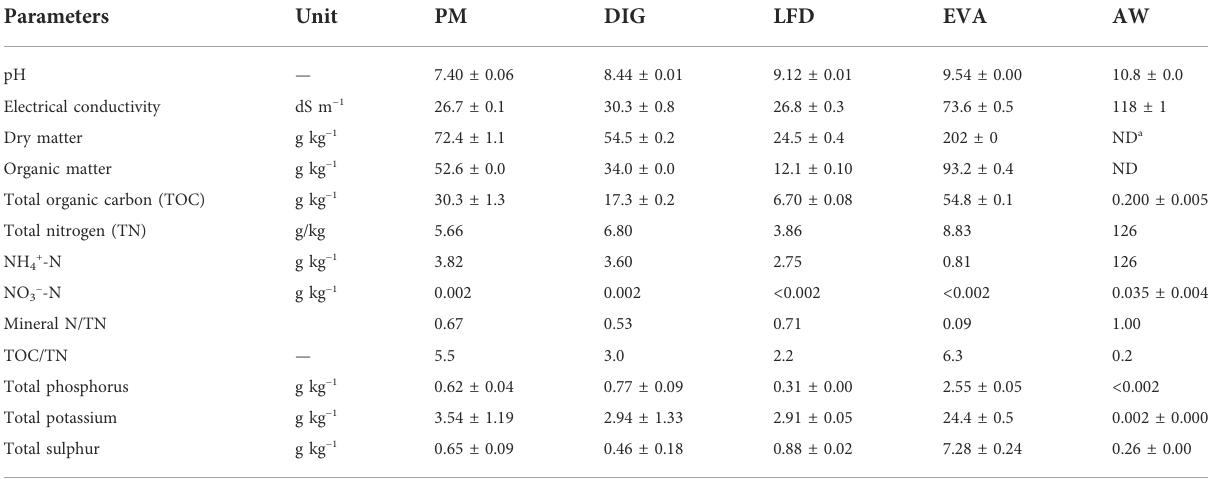
TABLE 1 Characterization of bio-based products ( n = 3) on fresh weight (FW) basis.